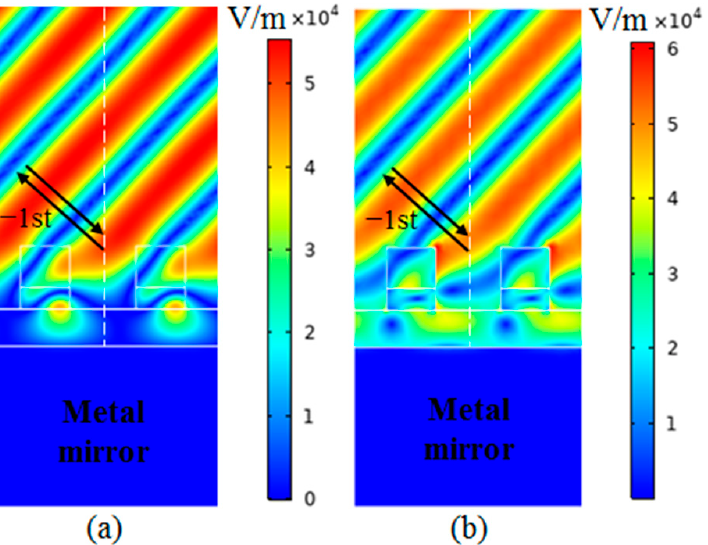
Figure 4. The electric field distributions of the grating at 1053 nm for ( a ) TE polarization and ( b ) TM polarization.